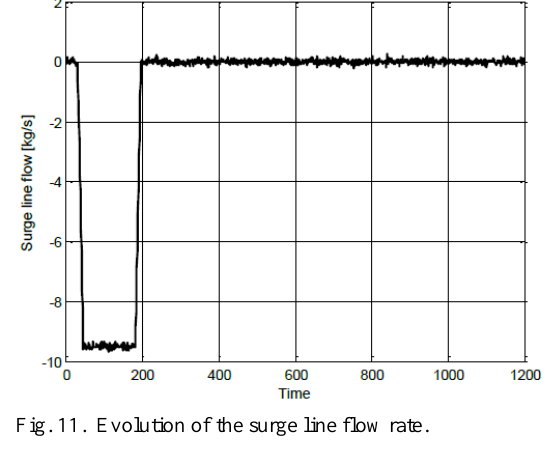
Fig. 10. Inputs, state, controller outputs (gray), controller inputs (black) and sensors outputs of the SIMULINK model of the pressurizer.